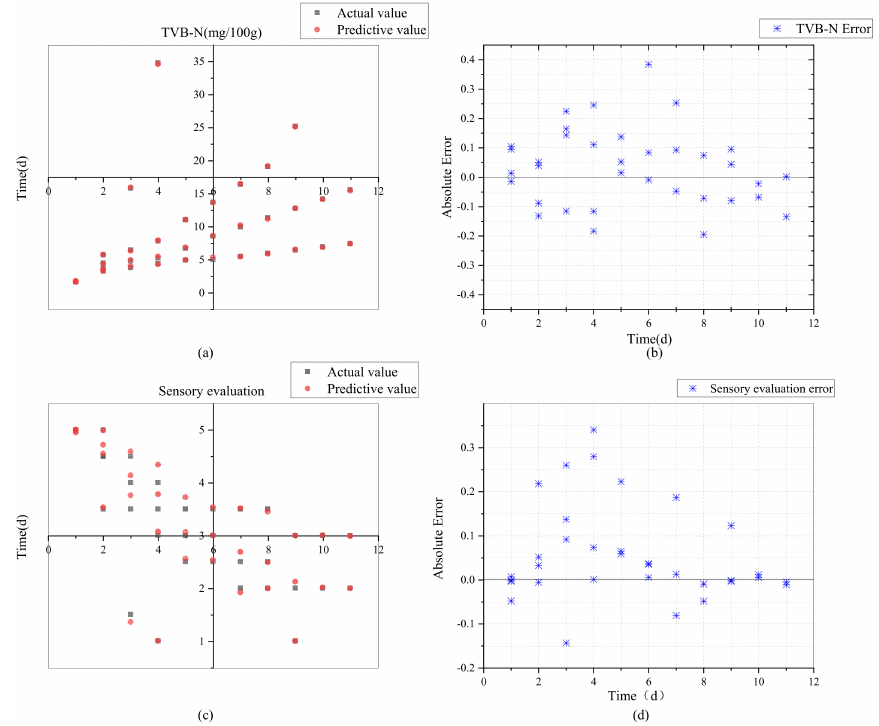
Figure 7. The performance analysis of the improved prediction model. ( a ) The absolute error of TVB-N; ( b ) The relative error of the TVB-N; ( c ) The absolute error of sensory evaluation; ( d ) The relative error of sensory